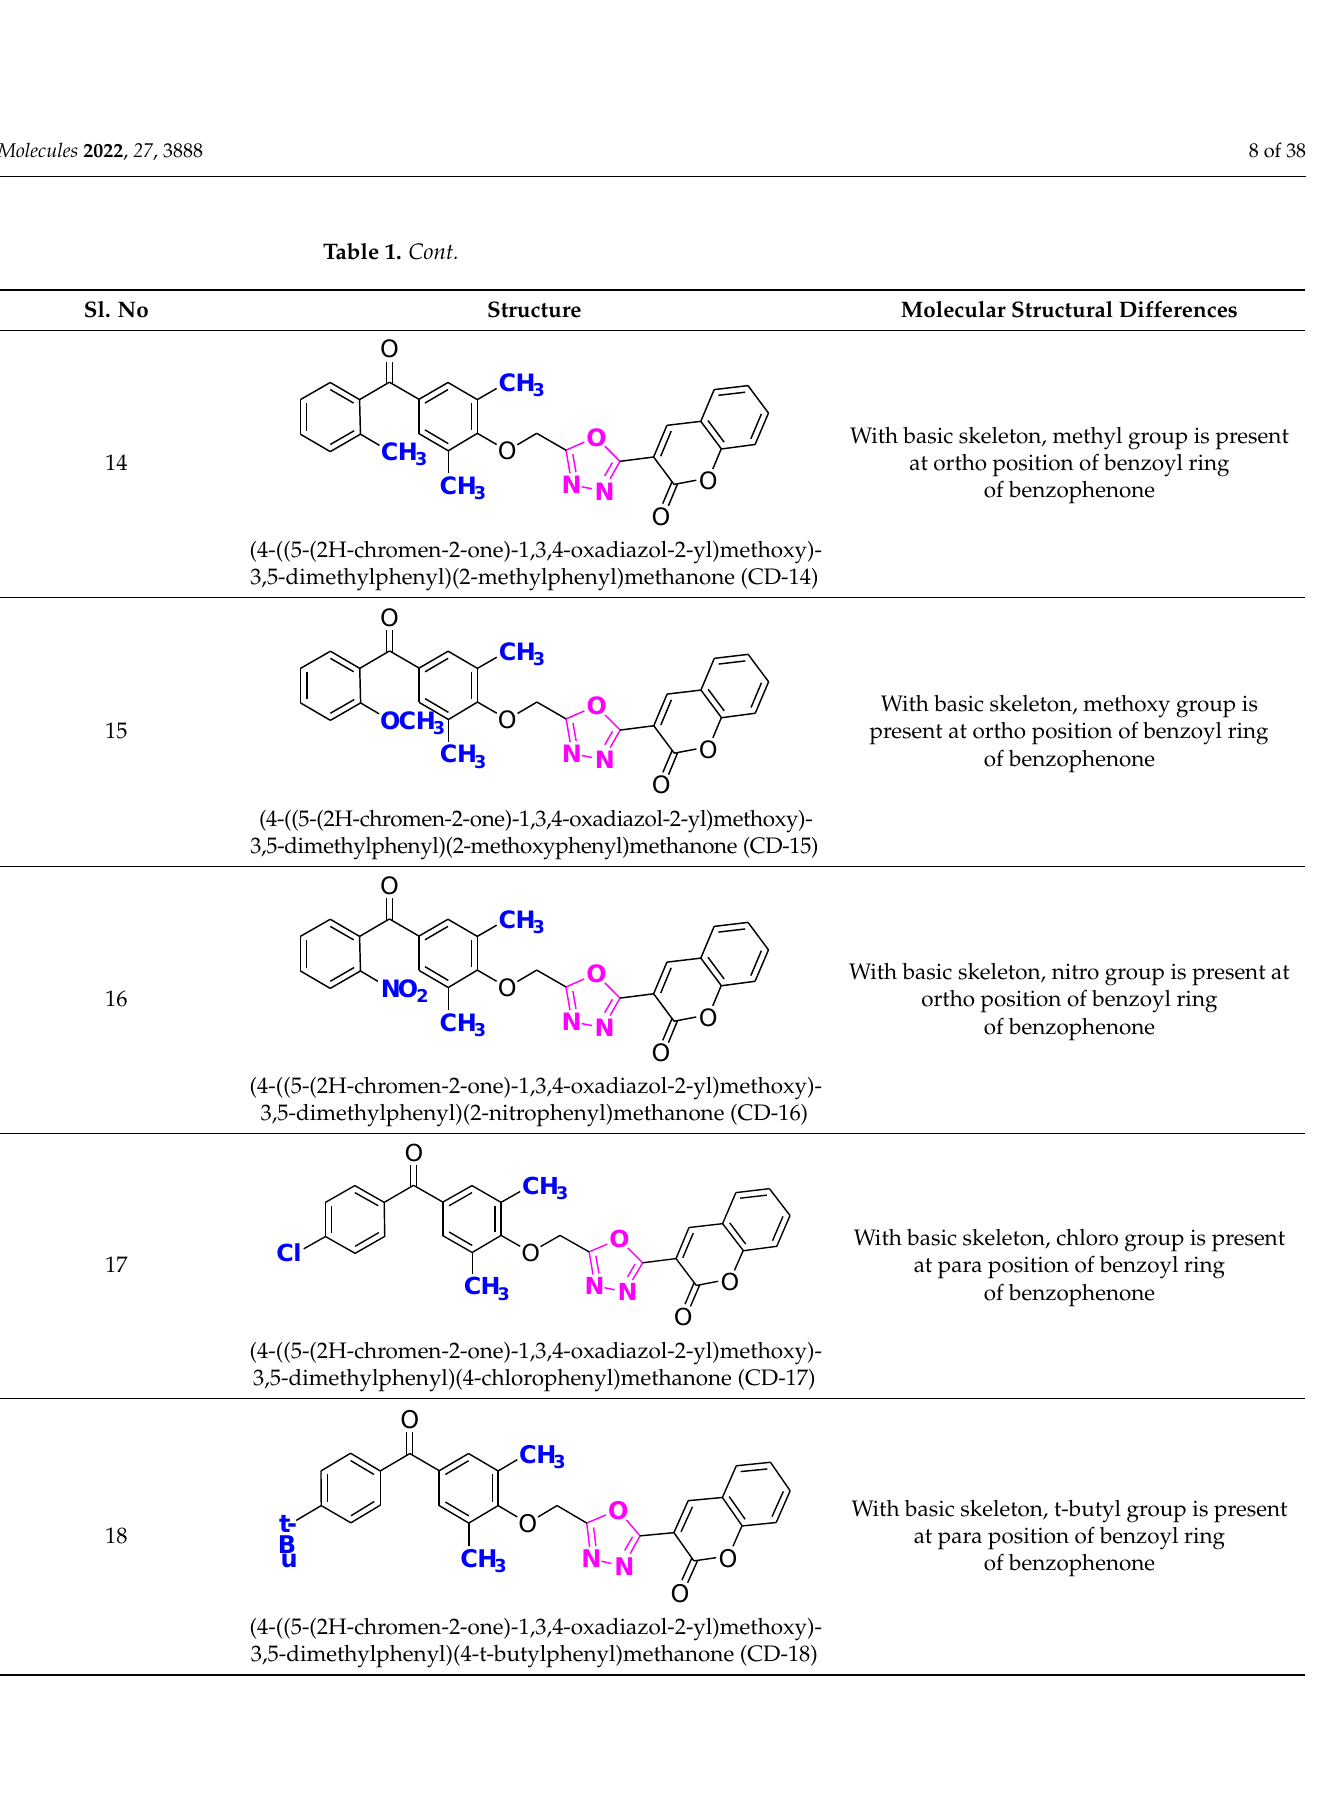
With basic skeleton, bromo group is